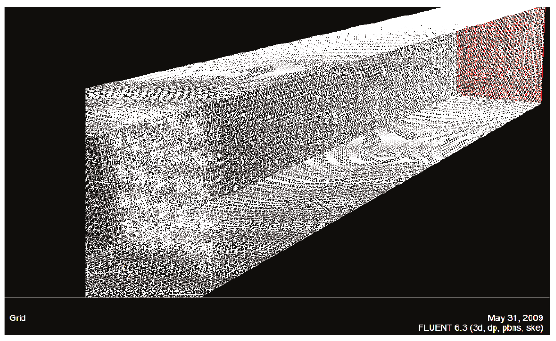
Figure 2. Flow through a woven sample – grid generation by using Fluent 6.3 CFD software